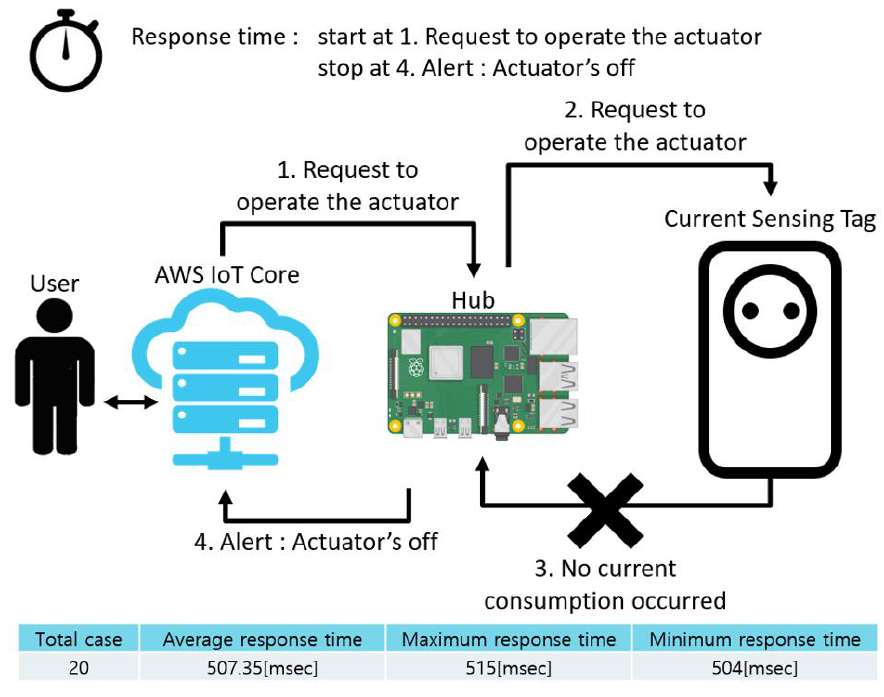
Figure 23. Response time in exceptional case: actuator off.